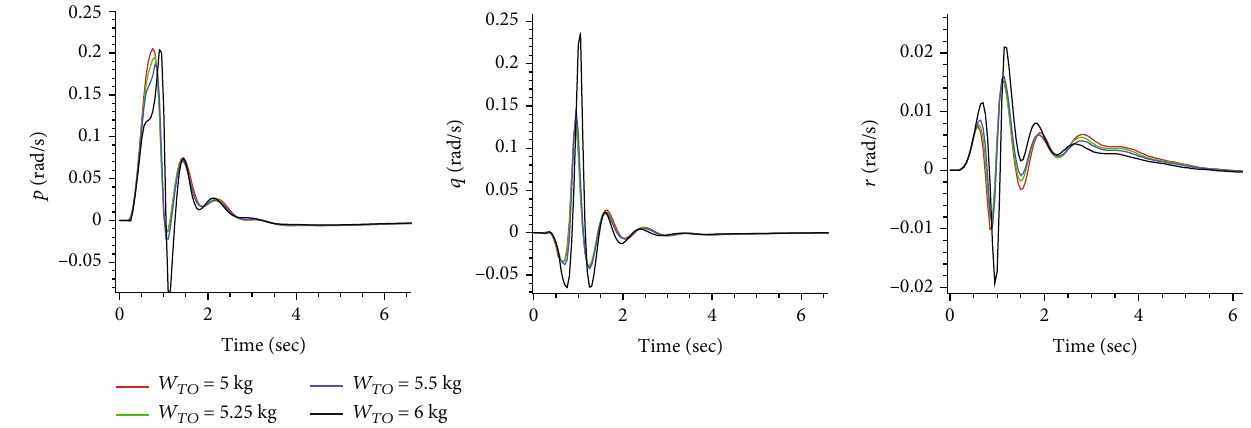
Figure 30: The angular rates of the Quad-Plane with di ff erent W